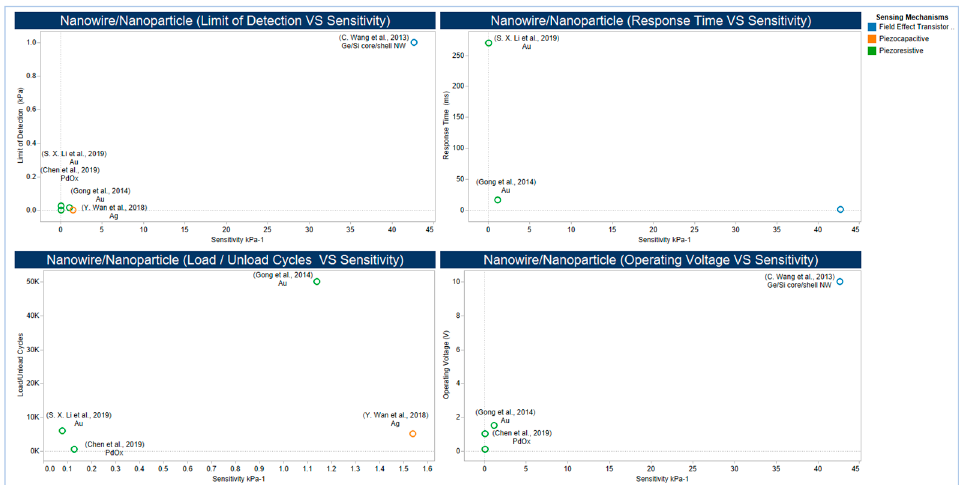
Figure 16. Effect of adoption ultrathin NWs and imprinting to control patterns and orientation of functional materials on sensor performance.